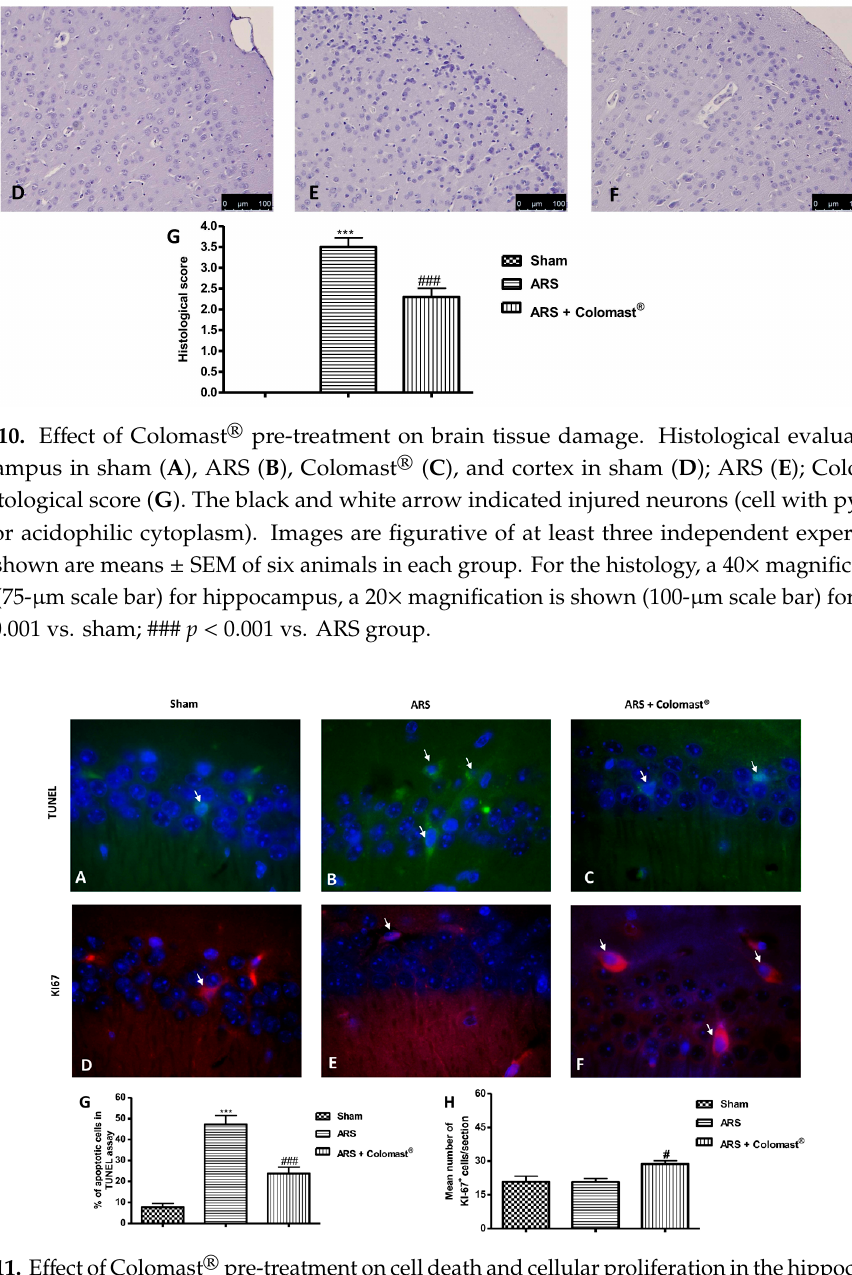
Figure 11. Effect of Colomast ® pre-treatment on cell death and cellular proliferation in the hippocampus. TUNEL staining of hippocampus sections: sham ( A ); ARS ( B ); Colomast ® ( C ); graphical quantification ( G ). Immunofluorescence of Ki-67 in hippocampus sections: sham ( D ); ARS ( E ); Colomast ® ( F ); graphical quantification ( H ). Images are figurative of at least three independent experiments. Values shown are means ± SEM of six animals in each group. For TUNEL staining and immunofluorescence, a 100× magnification is shown (25-µm scale bar). *** p < 0.001 vs. sham; # p < 0.05 vs. ARS group; ### p < 0.001 vs. ARS group.